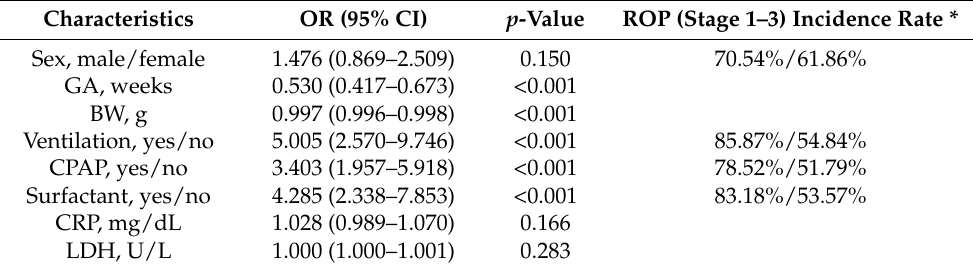
Table 3. Univariate binary logistic regression analysis results. GA, BW, Ventilation, CPAP, and surfactant treatment were found to be significant ROP (Stage 1–3) risk